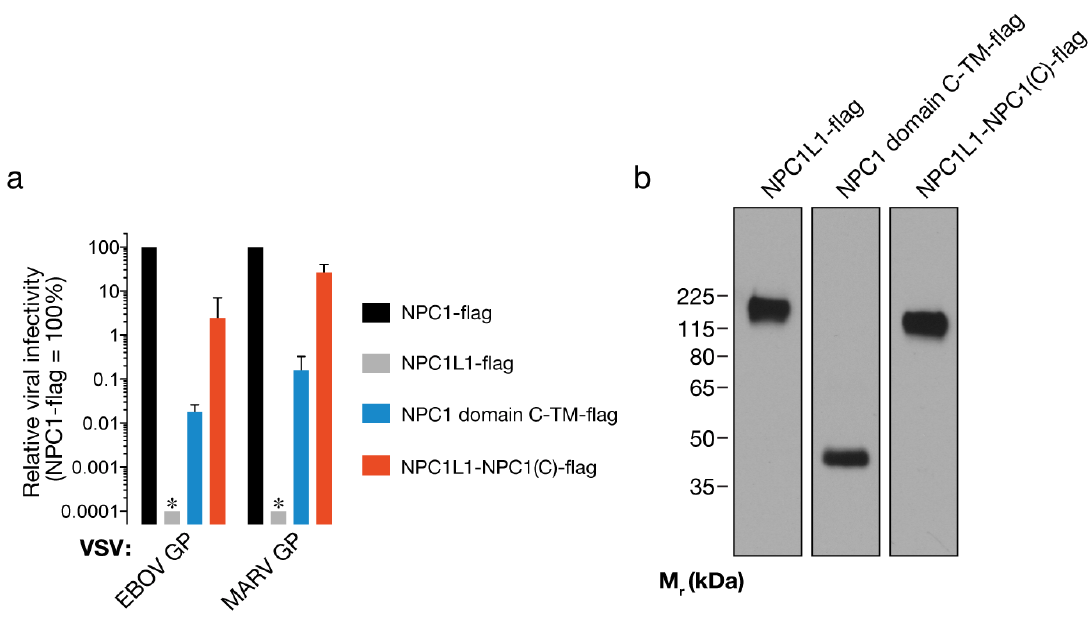
Figure 3. NPC1L1 sequences greatly enhance the capacity of NPC1’s domain C to mediate filovirus entry. (a) Infection of CT43 cells expressing NPC1-flag, NPC1L1-flag, NPC1 domain C fused to NPC1’s transmembrane domain (NPC1 domain C-TM-flag),